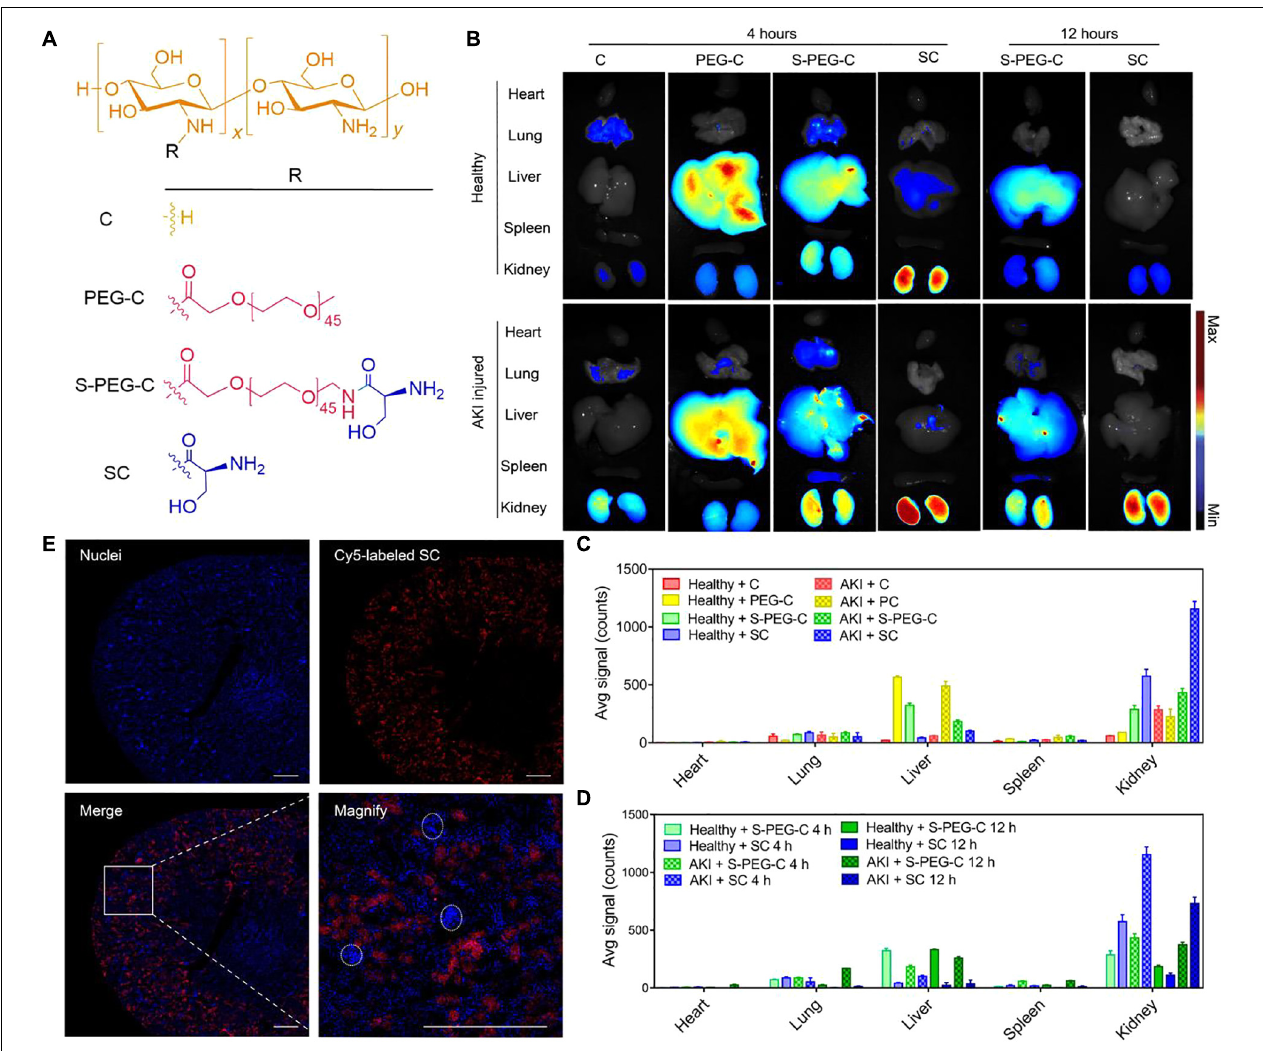
FIGURE 5 | Renal distribution and renal tubules accumulation of l-serine–modified chitosan (SC). Reprinted with permission (Liu et al., 2020). (A) The chemical structures of SC and its analogies (B) Fluorescence images of the main organs (heart, lung, liver, spleen, and kidney) of mice at 4 or 12 h after intravenous injection of Cy5-C, Cy5-PEG-C, Cy5-S-PEG-C, or Cy5-SC. One of three independent experiments is shown. Renal ischemia was induced by clamping of the bilateral renal pedicles for 30 min and then removed clamping to induce IR AKI. After the initiation of AKI, fluorescence-labeled SC and its analogies were administered intravenously. Four or twelve hours later, the main organs were harvested for fluorescence visualization. The healthy mice were treated with the same protocol as control. (C,D) Region of interest analysis of the kidney uptake at 4 and 12 h after injection. The data are the means ± SD. n = 3 independent mice. (E) Representative confocal images of kidney sections after intravenous injection of Cy5-SC (red signal) for 4 h. Blue indicates 4 (cid:48) ,6-diamidino-2-phenylindole (DAPI) staining. White dashed circles denote glomeruli. Scale bars, 500 µ